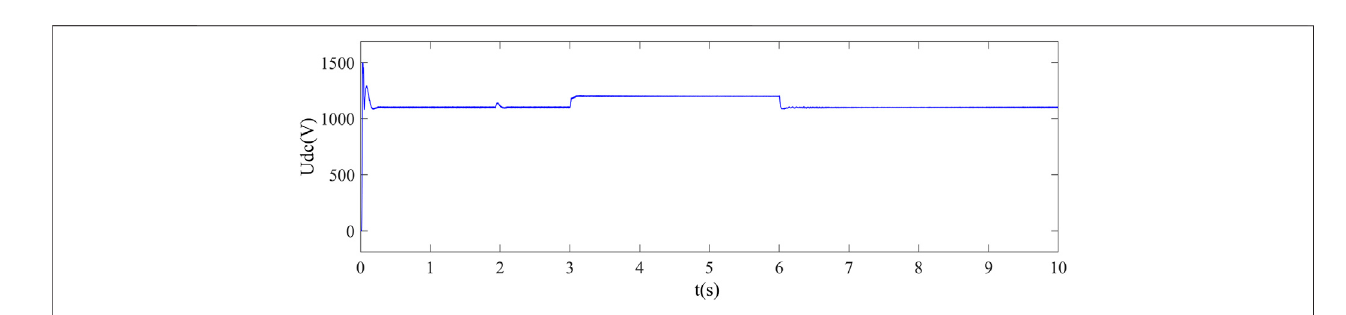
FIGURE 7 | Change of the dc-link